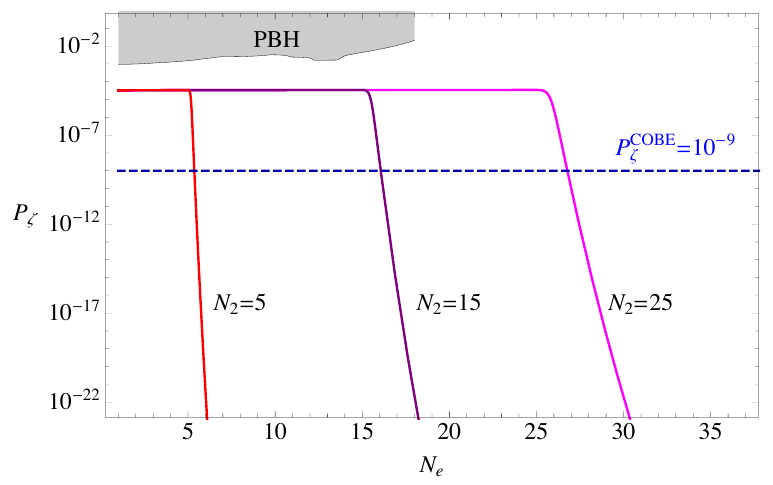
Figure 2 . We show the power spectrum as a function of the number of e-folds from the end of in(cid:13)ation. We have (cid:12)xed (cid:3) wig = 10 GeV, and f = 10 16 GeV. The three curves correspond to values of the axion-photon coupling, c (cid:13) , so that the number of e-folds in regime 2 [see eq. (8.6)] is 5, 15, D and 25, respectively. The curves are (cid:13)at in regime 2 [see eq. (7.4)], and fall exponentially in regime 1 [eq. (7.3)]. On the horizontal axis, time increases from right to left. The gray region shows the bound from PBH, computed following refs. [33, 49]. Such a bound is typically very stringent for natural in(cid:13)ation models, but here it is easily evaded due to the signi(cid:12)cantly lower in(cid:13)ation scale. Note that while it is numerically possible to explain the observed P (cid:16) = around N e = 30, we P COBE see that the lines fall very steeply, due to the exponent in eq. (7.3). This indicates that it is di(cid:14)cult for the model as it stands to predict the observed curvature